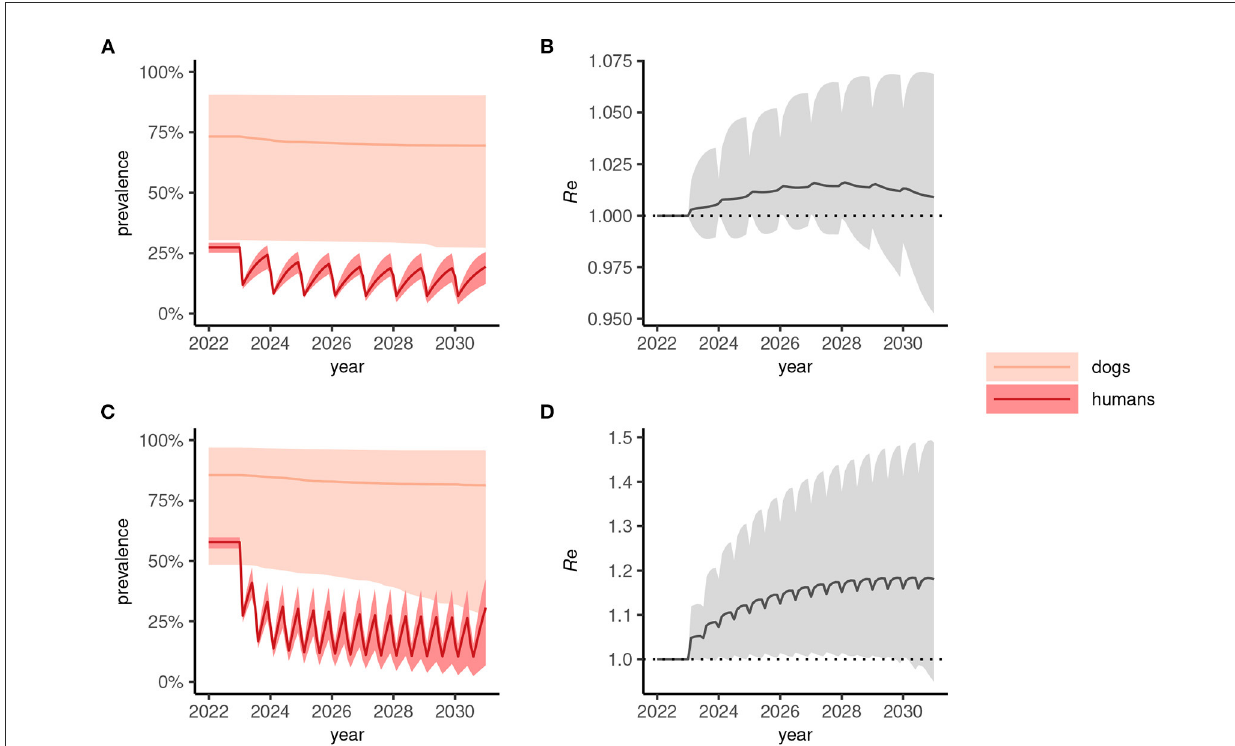
FIGURE3 Dynamics of Anyclostoma ceylanicum infection prevalence during 8 years of human-only mass drug administration (MDA) simulated using the multi-host transmission dynamics model. For illustration, parameter sets were selected that gave an endemic prevalence in humans of 25–30 % (A) and 60–65 % (C) . The solid colored lines indicate the median prevalence of infection (from the sampled parameter sets) in dogs and humans (as indicated) during annual (A) or biannual (C) MDA at 75 % coverage and the lighter shaded areas indicate the extent of the 5th and 95th percentiles. The associated effective reproduction numbers, R e , are shown in (B) and (D) , the solid line indicating the median and the shaded gray area the 5th and 95th percentiles. Below the threshold R e = 1, transmission is interrupted and the parasite population tends to